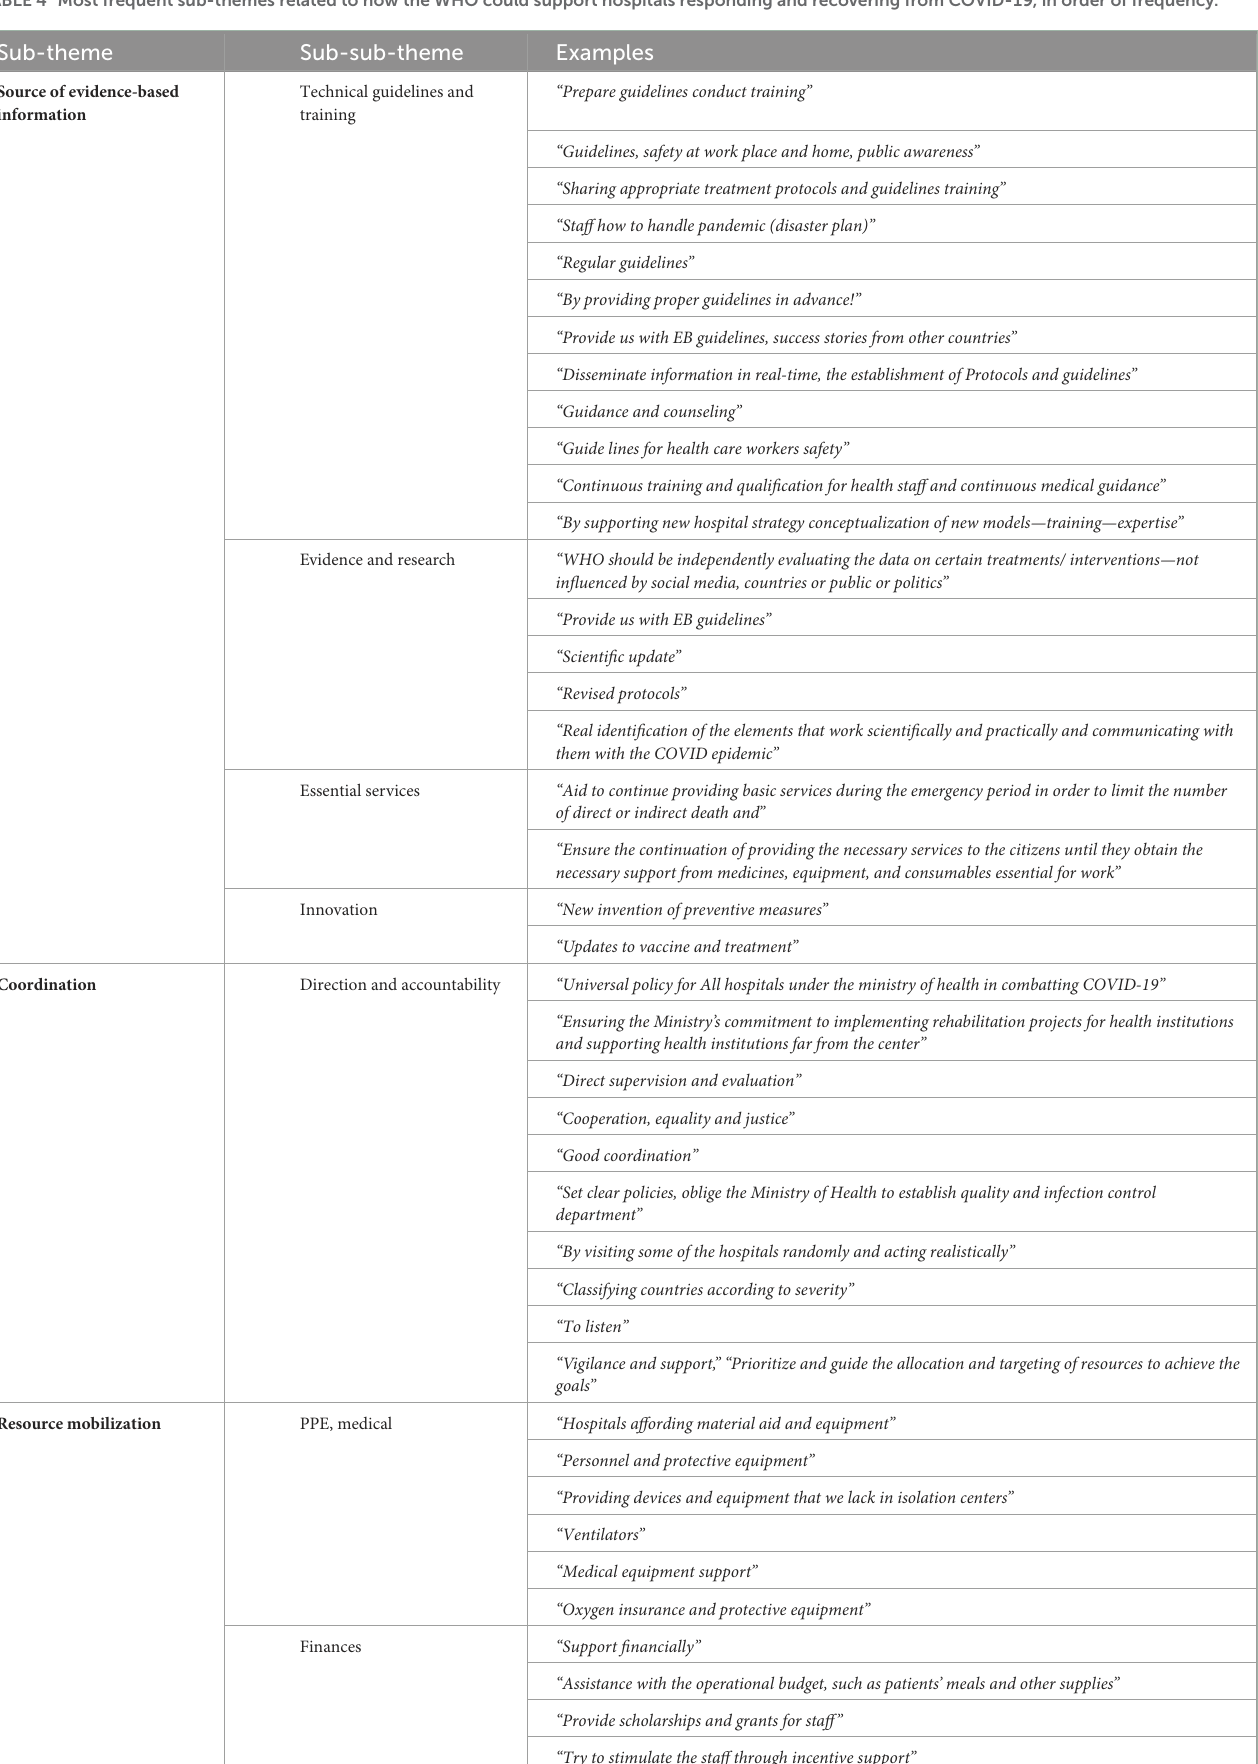
TABLE 4 Most frequent sub-themes related to how the WHO could support hospitals responding and recovering from COVID-19, in order of